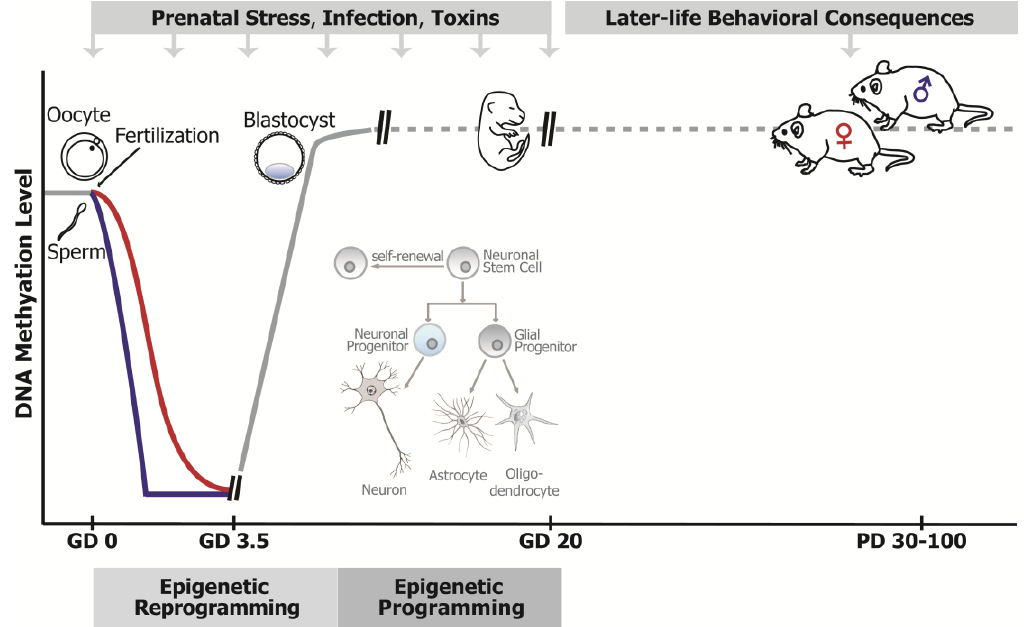
Figure 1. The epigenome as a substrate for the lasting effects of prenatal stressors on brain function and behavior. The epigenome is particularly vulnerable to disruption by environmental agents during prenatal development, when an extensive reprogramming and programming of epigenetic modifications takes place. The post-fertilization “epigenetic reprogramming” (zygote to blastocyte stage) includes the almost complete erasure of DNA methylation in both the paternal (blue line) and the maternal (red line) genome, which is then re-established (solid gray line), leading to differential DNA methylation and gene expression patterns in the first cell lineages. In the later stages of development, epigenetic marks are less dynamic (dashed gray line), but still actively participate in gene expression programming, relevant for later stages of cellular differentiation (“epigenetic programming”). As an example, during the differentiation of brain cells (see picture inset), DNA methylation and histone modifications are involved in the gene expression programming that differentiates neuronal stem cells into neuronal and glial progenitors, and further into more specialized neuronal and glial cells (astrocytes and oligodendrocytes). Hence, prenatal exposure to environmental factors that affect the epigenome (stress, infection, toxins) can disrupt gene expression programming in the embryo/fetus, resulting in developmental deficits, including abnormal brain development that can lead to later-life behavioral disorders. Importantly, the epigenome is also dynamic in mature, postmitotic neurons (depicted as a dashed gray line postnatally), so long-term behavioral abnormalities may also result from the improper developmental programming of the brain’s epigenetic machinery that continues to be used by mature